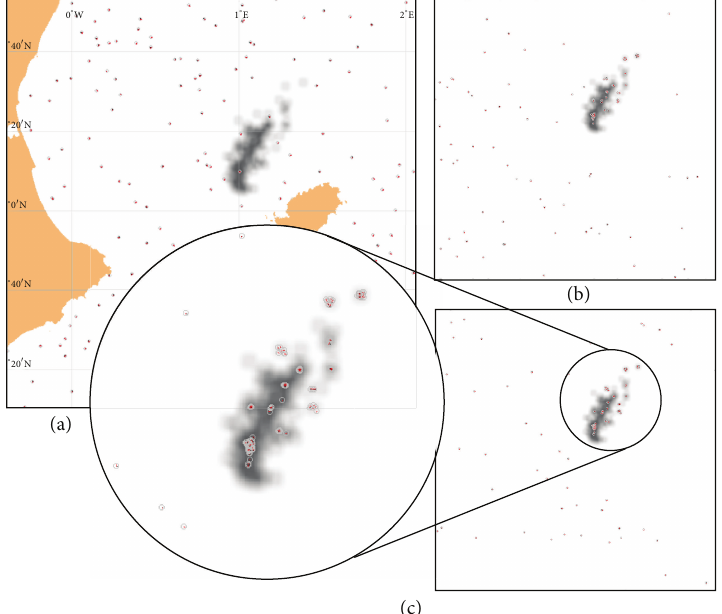
Figure 4: Distribution of agents for the task of covering the spill ( 𝛾(𝑆) = 1 ): (a) geographical location of the slick and initial position of agents, (b) position of agents at time 𝑡 = 15000 s, (c) position of agents at time 𝑡 = 30000